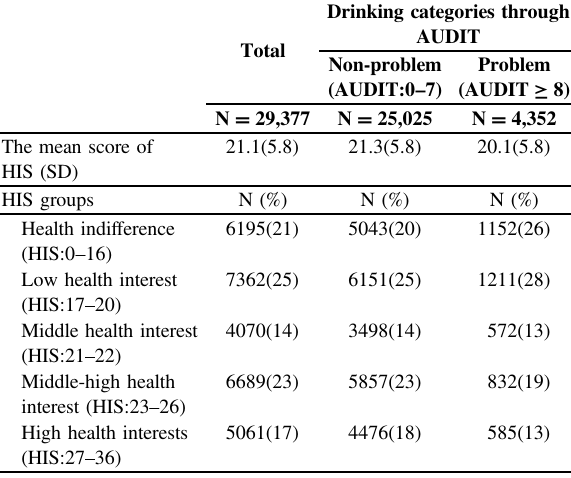
Table 2 The distribution between Health Interests Scale